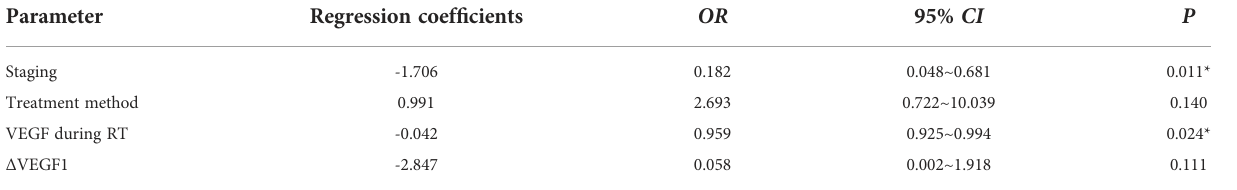
TABLE 3 Multivariate logistic regression analysis for factors affecting ef fi cacy.